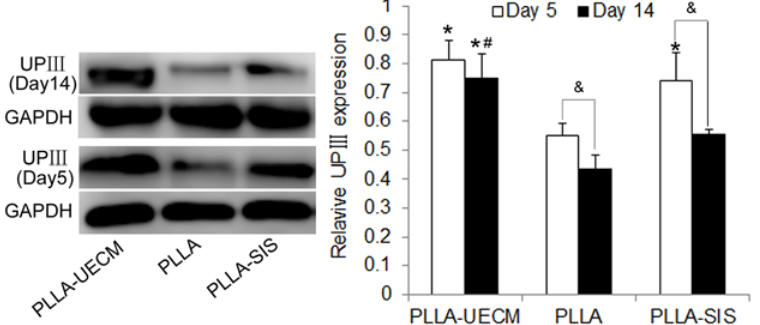
Fig 4. Western blot analysis for the specific marker (UPIII) of UCs. Left: UPIII expression at day 5 and day 14 in the three different scaffolds. Right: Semi-quantitative data for the relative protein expression levels (UPIII /GAPDH). * : p < 0.05 versus the PLLA group; #: p < 0.05 versus the PLLA-SIS group. &: p < 0.05 versus UPIII expression at day 14 in the same scaffold.